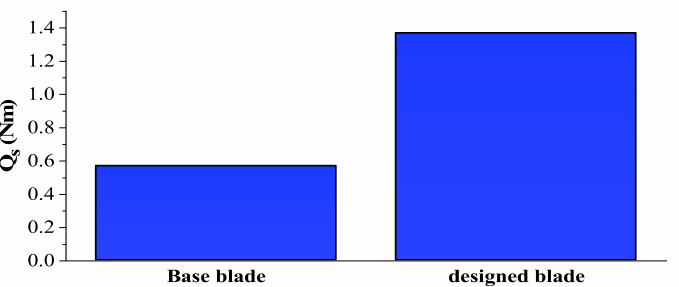
Figure 19. The Q s values generated by the base/designed blades.